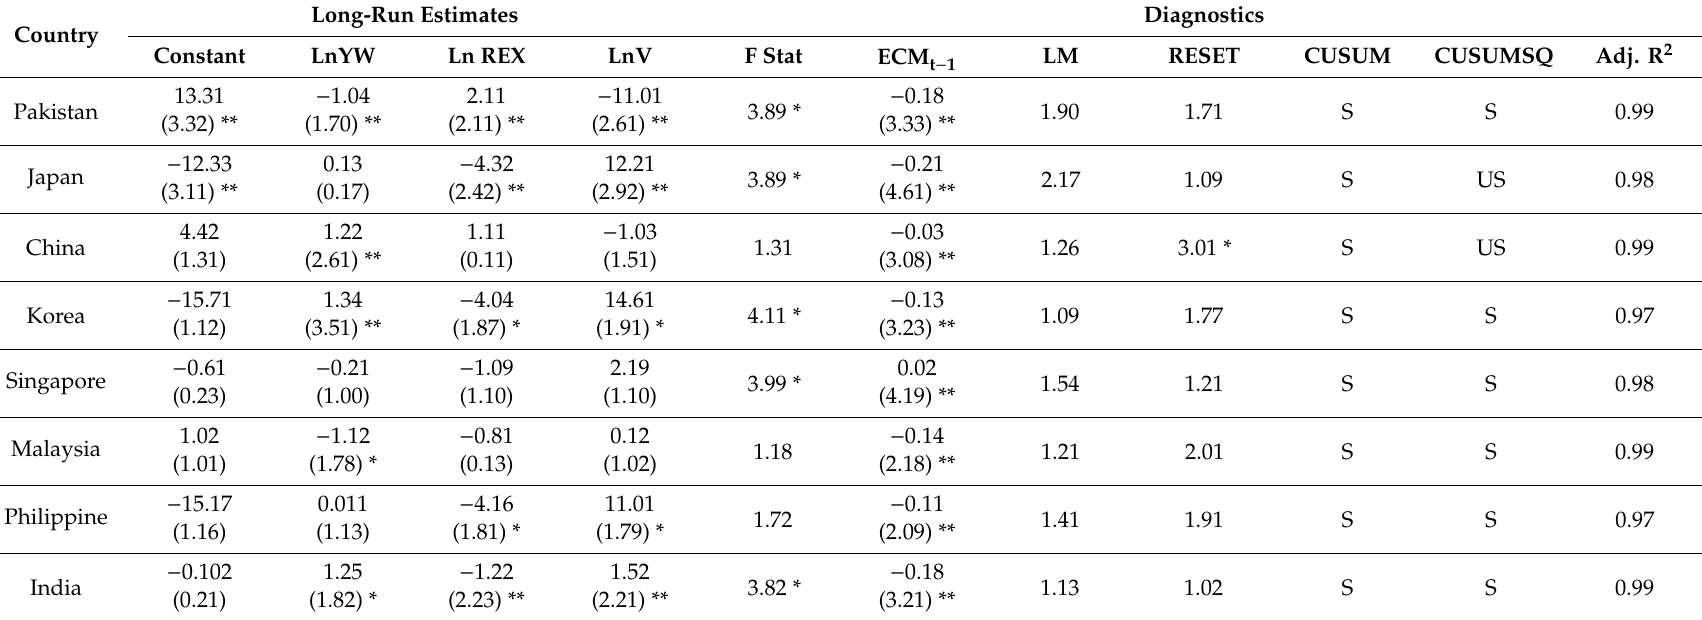
Table 2. Long-Run Coe ffi cient Estimates and Diagnostic Statistics Associated with Linear Export Demand Models in Table 1. Long-Run Country